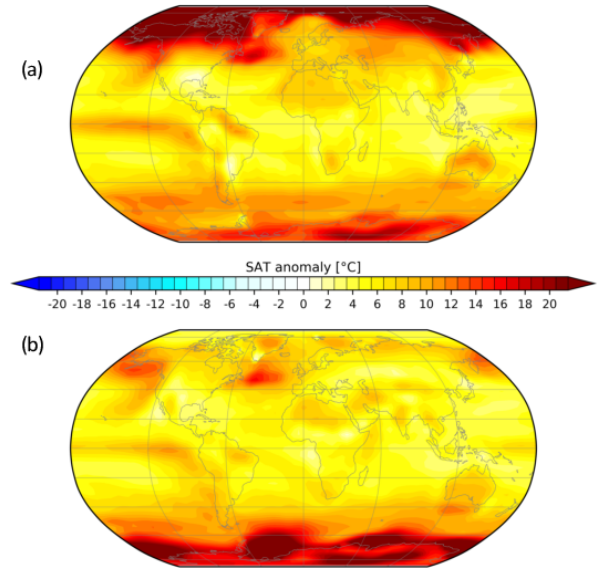
Figure 10. Anomalous near-surface temperature for the vertical mixing experiment relative to the control climate. (a) Mean over boreal winter and austral summer (DJF). (b) Mean over austral win- ter and boreal summer (JJA). Shown is the 100-year mean after 900 years of integration using the Earth system model COSMOS. Val- ues are given in ◦